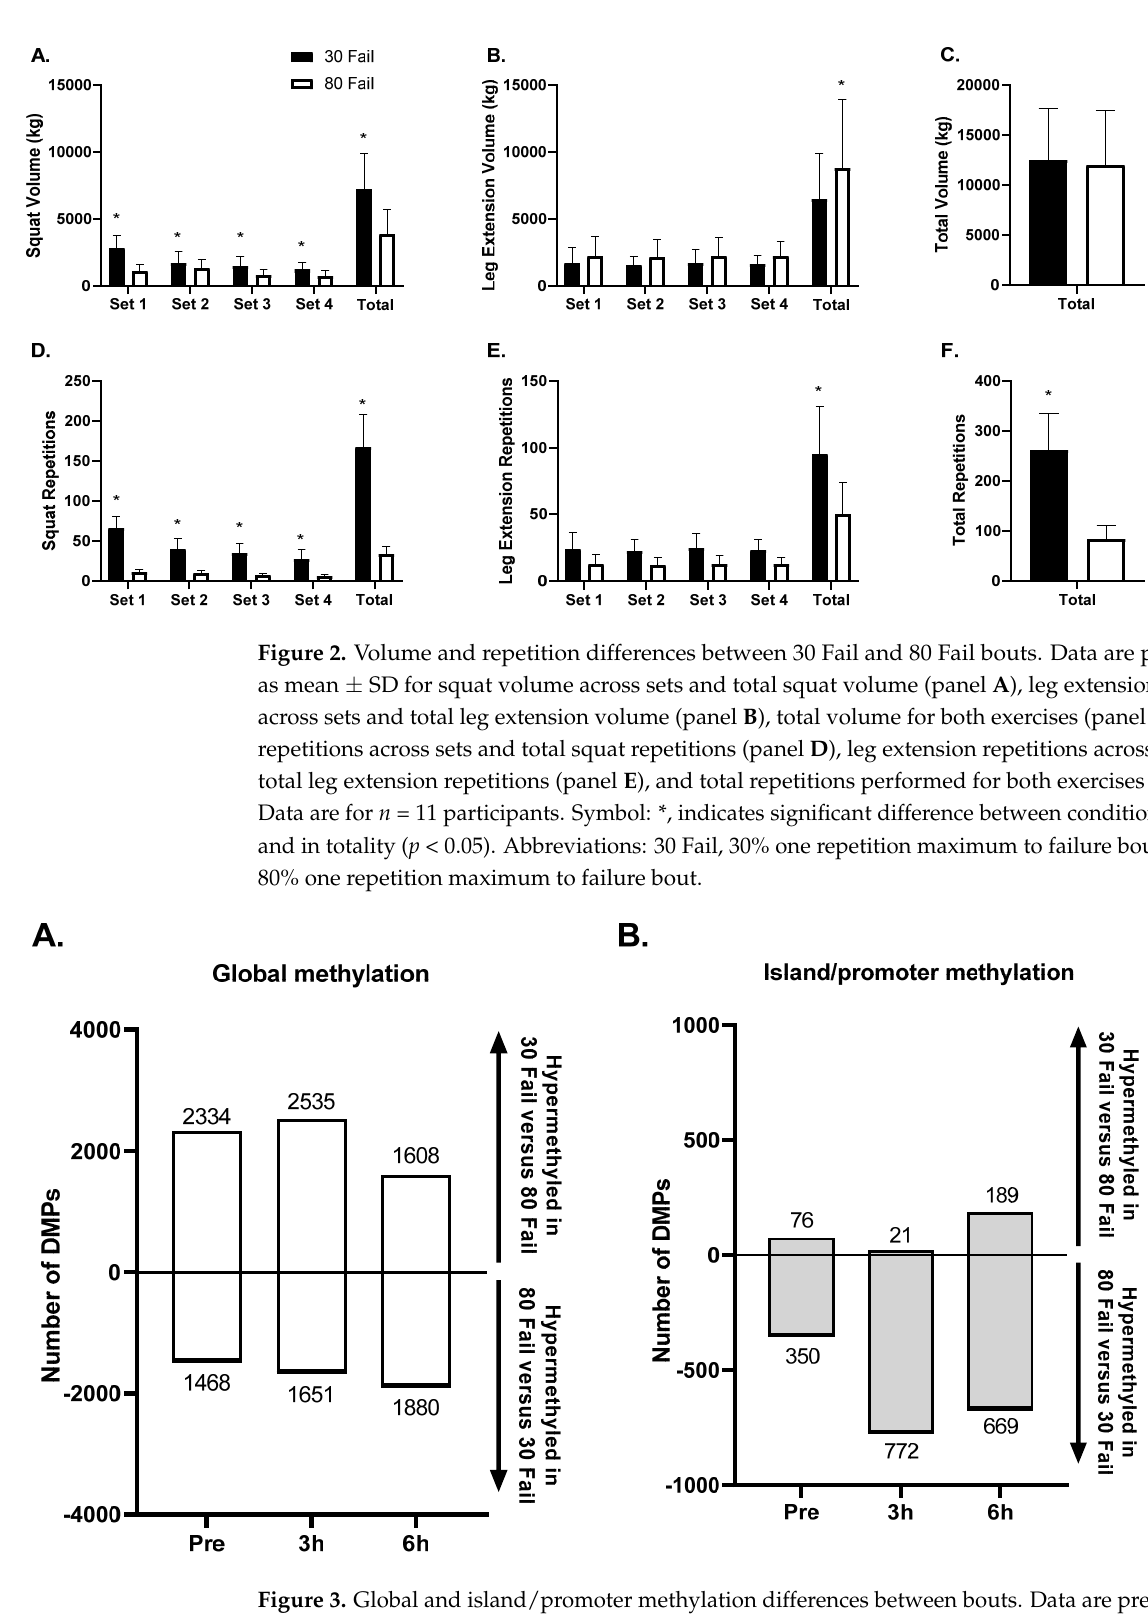
Figure 3. Global and island/promoter methylation differences between bouts. Data are presented as total number of significant differentially methylated positions (DMPs) in 30 Fail compared to 80 Fail (panel A ), and DMPs present in islands and promoters (panel B ). Data are for n = 11 participants and significance was established as p < 0.01 between conditions at each time point. Abbreviations: 30 Fail, 30% one repetition maximum to failure bout; 80 Fail, 80% one repetition maximum to failure bout.